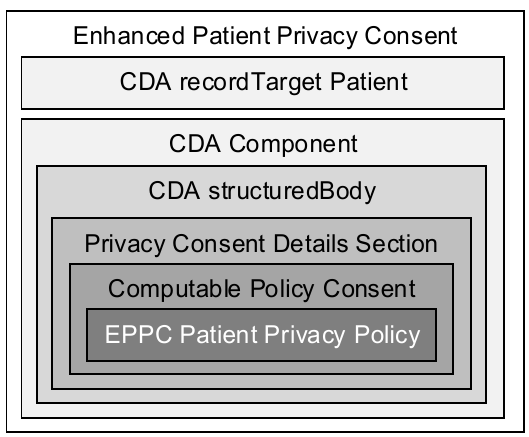
Figure 5: Structure of an Enhanced Patient Privacy Consent Document Figure 5. Structure of an Enhanced Patient Privacy Consent document